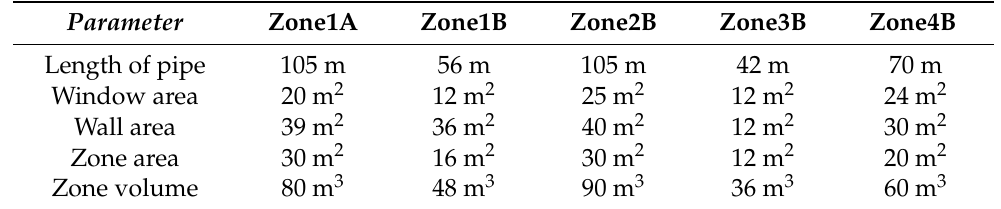
Table 2. Parameters used for each temperature zone. A and B refer to if it is the one-zone simulation or the four-zone